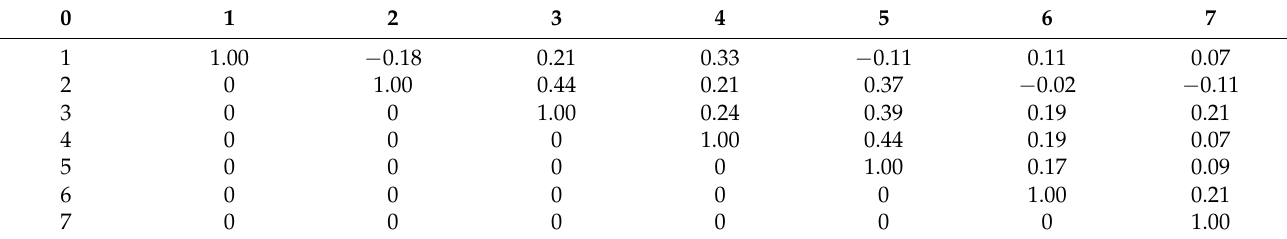
( 3 ) ( i ) ; ν ,i = 1,7 (preceding 1 ν